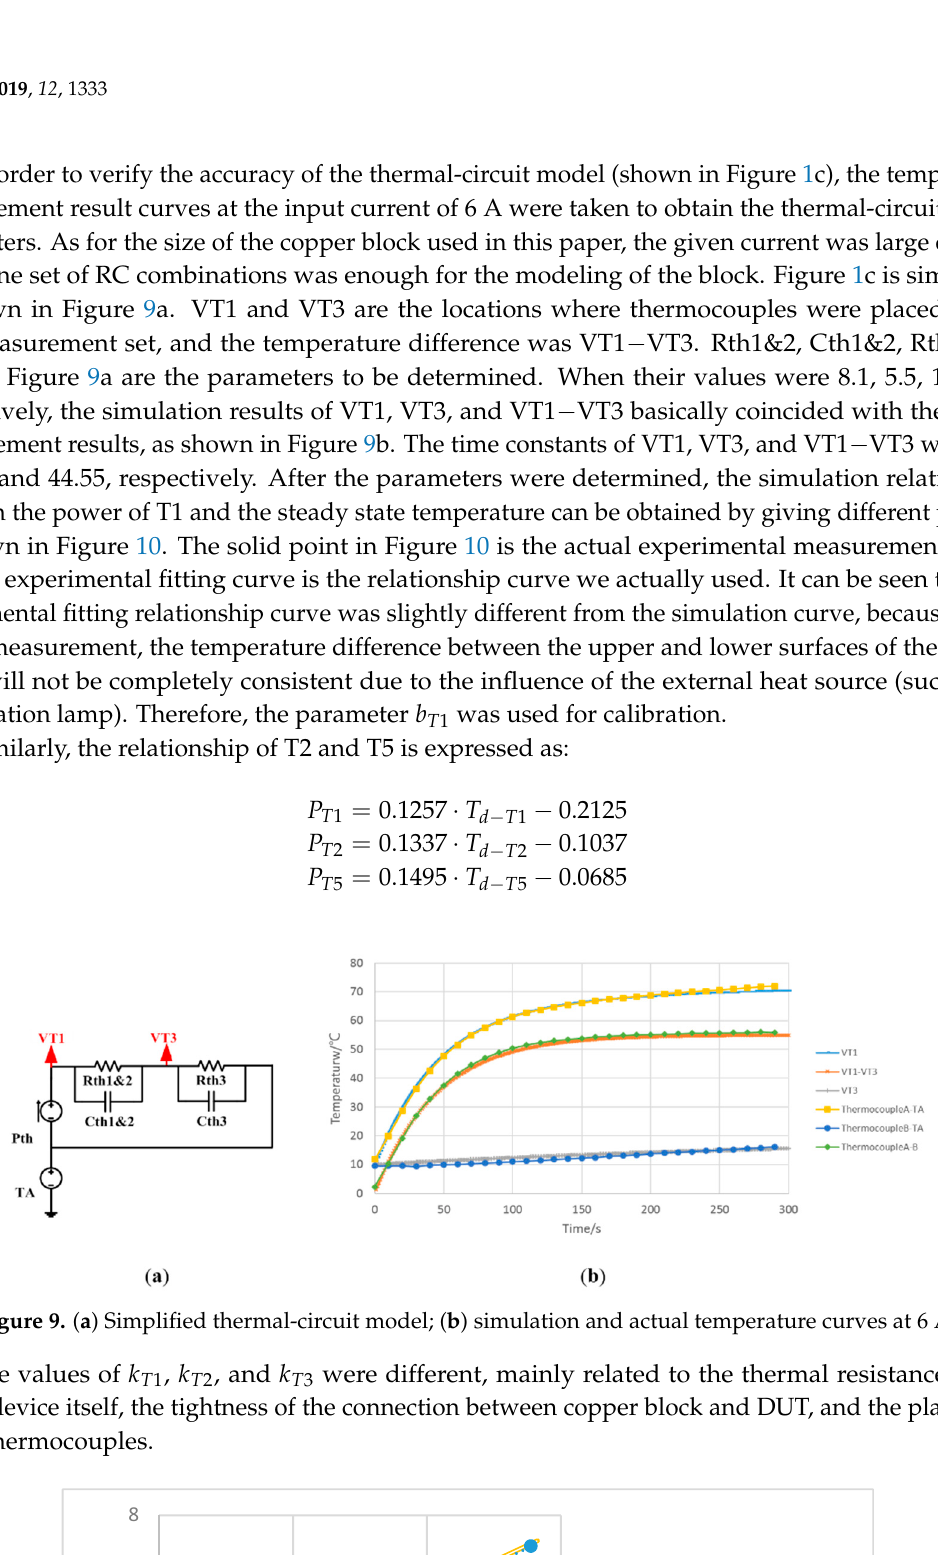
y = 0.1257x - 0.2125 R² = 0.9997